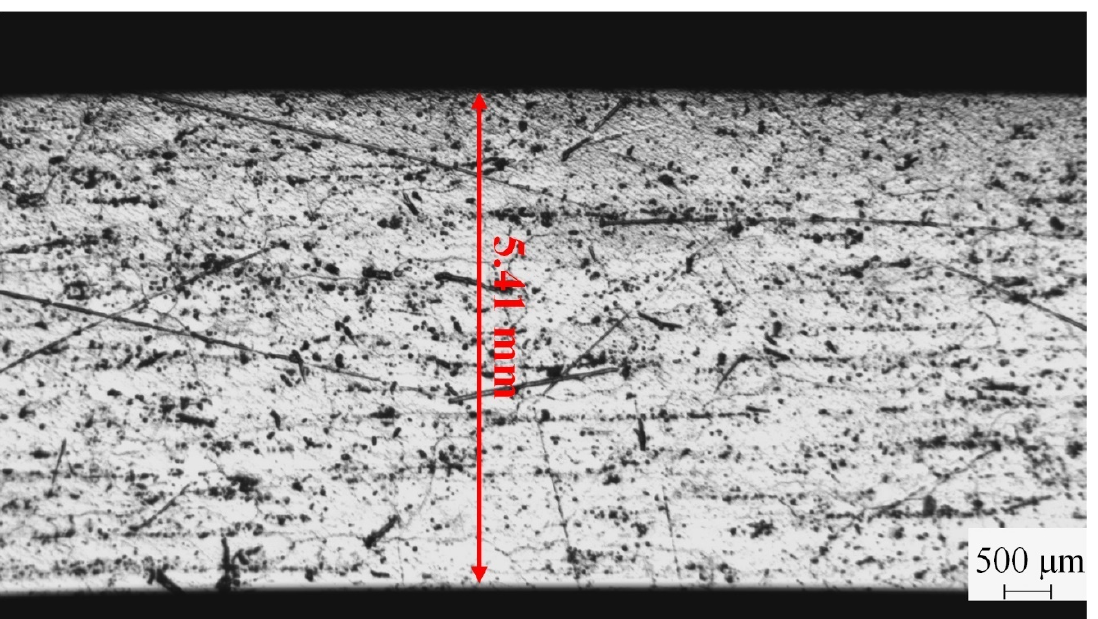
Figure 4. Waveform matches at different correlation coefficients.